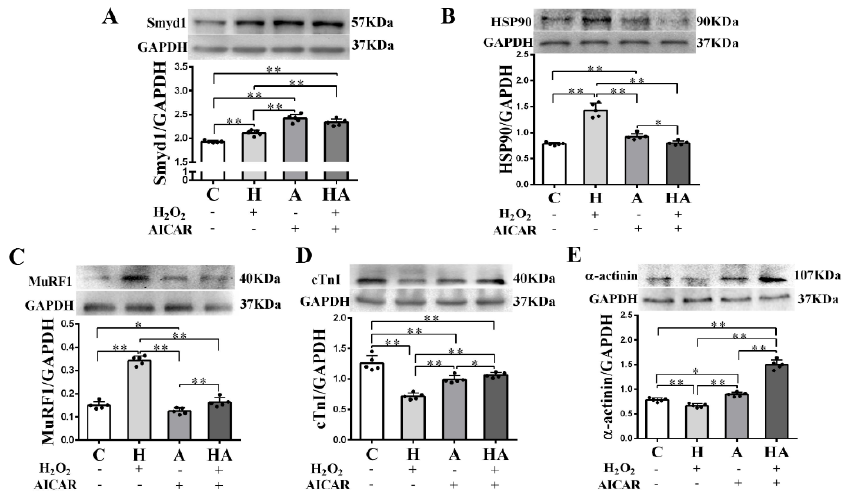
Figure 7. E ff ects of H 2 O 2 and AICAR on expression of Smyd1 and cytoskeleton-associated proteins in H9C2 rat cardiomyoblasts in vitro: Western blot results of Smyd1 ( A ), HSP90 ( B ), MuRF1 ( C ), cTnI ( D ), and α -actinin ( E ) expressions in H9C2 cells. Data are expressed as mean ± Standard Deviation (SD), n = 5 / group. Symbols indicate * p < 0.05 and ** p < 0.01. Abbreviations: C, Untreated control group; H, H 2 O 2 -treated group; A, AICAR-treated group; and HA, H 2 O 2 + AICAR cotreated group.